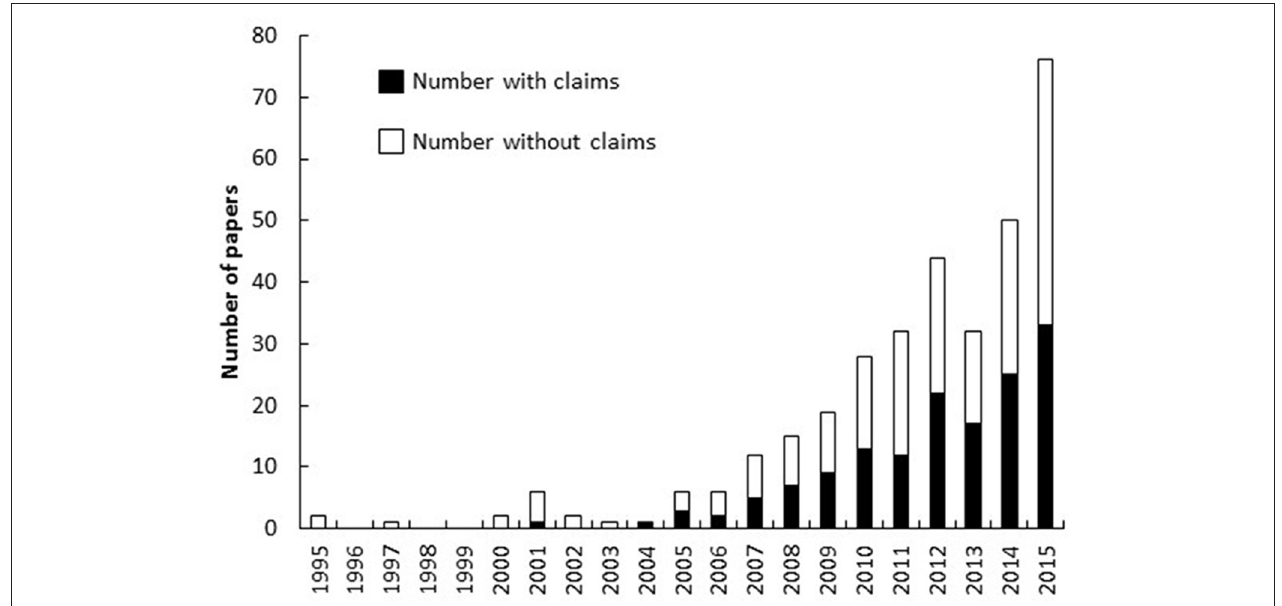
FIGURE 2 | Number of papers published on the topic of “jellyfish blooms” each year that do and do not make claims that anthropogenic stressors cause jellyfish blooms.